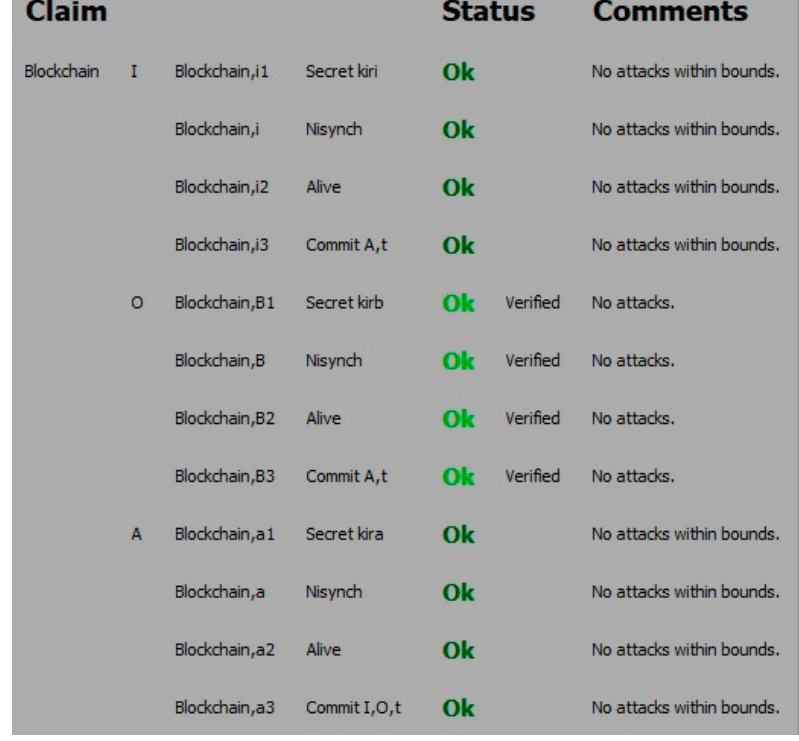
Figure 2. The output for the Scyther claim test for I, B and A.